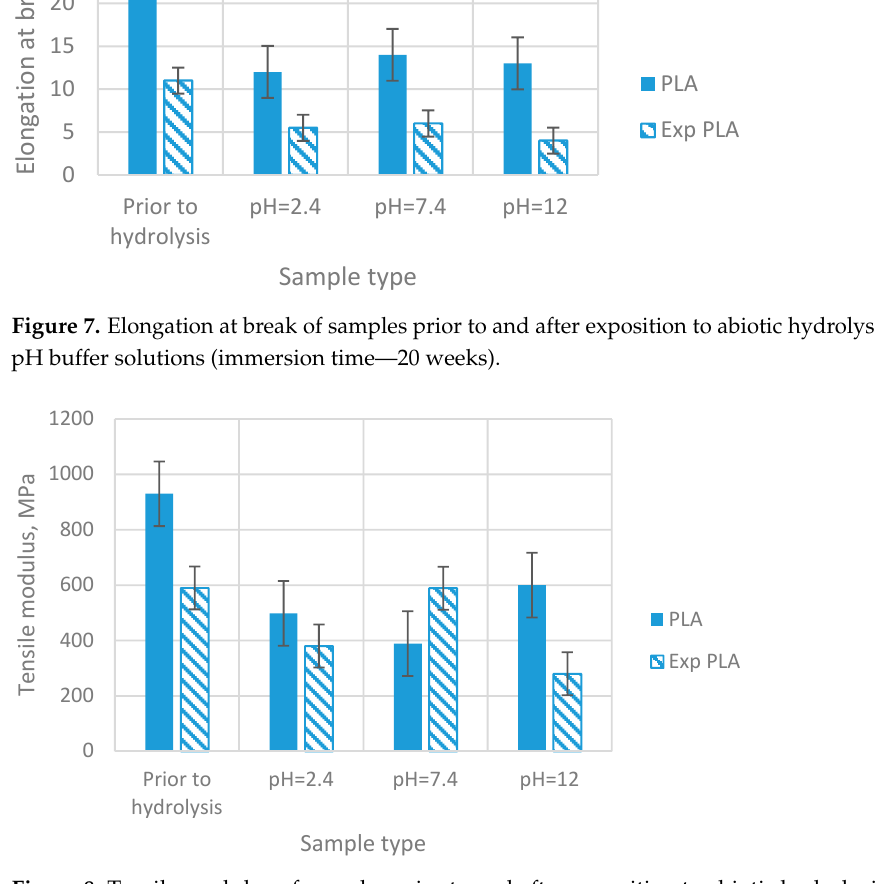
Figure 8. Tensile modulus of samples prior to and after exposition to abiotic hydrolysis in various pH buffer solutions (immersion time—20 weeks).